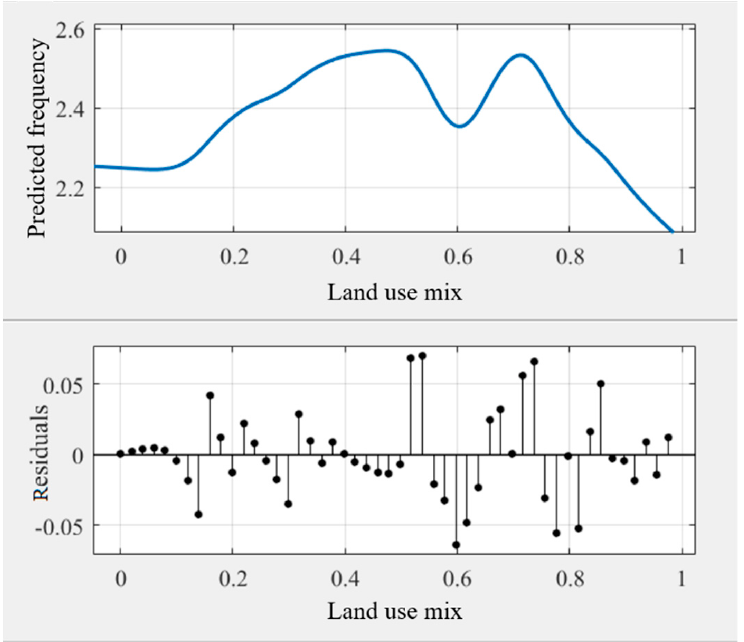
Figure 5. Nonlinear associations between land-use mixture (MIX) and cycling frequency among older adults.